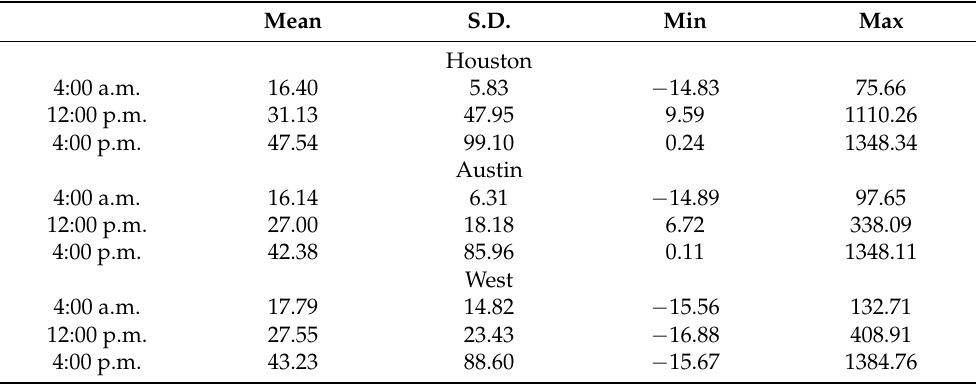
Table 1. Summary statistics of the hourly prices ($/MWH) for Houston, Austin, and the